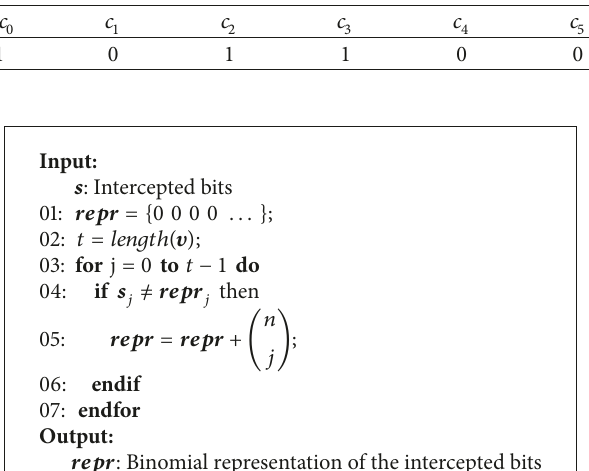
Algorithm 1: Constructing the binomial representation of a given